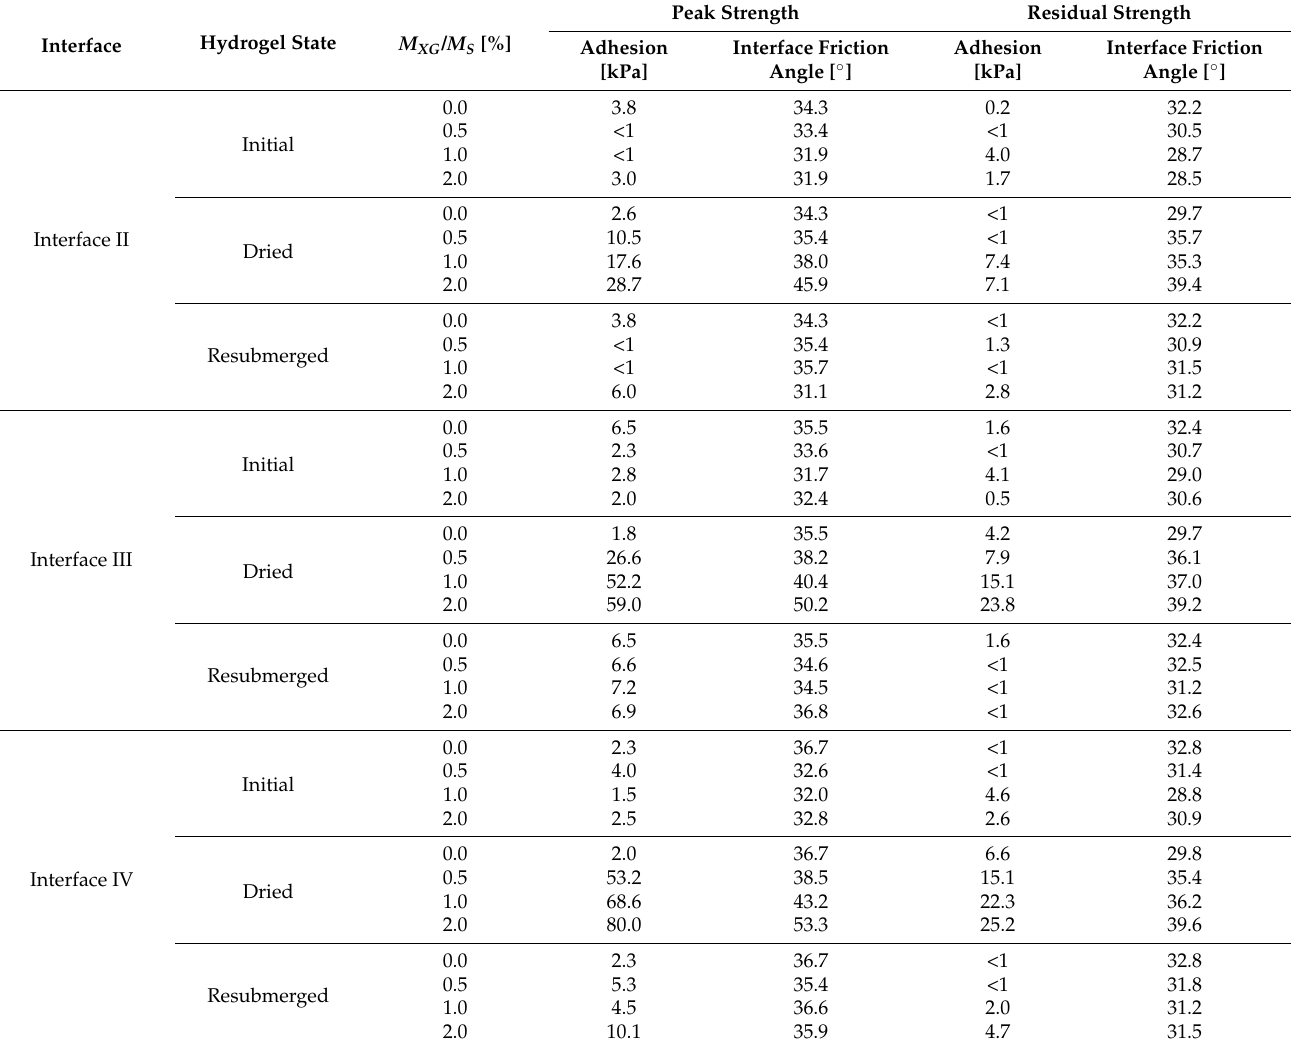
Table 6. Mohr–Coulomb failure parameters determined from linear regression (interface II, III, and